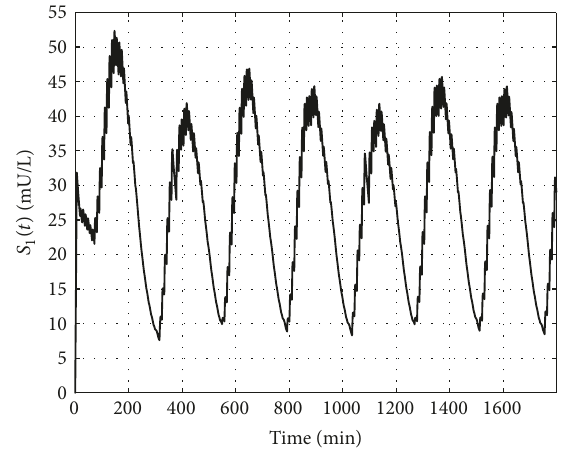
Figure 12: Variation of the first state of the glucose absorption subsystem.